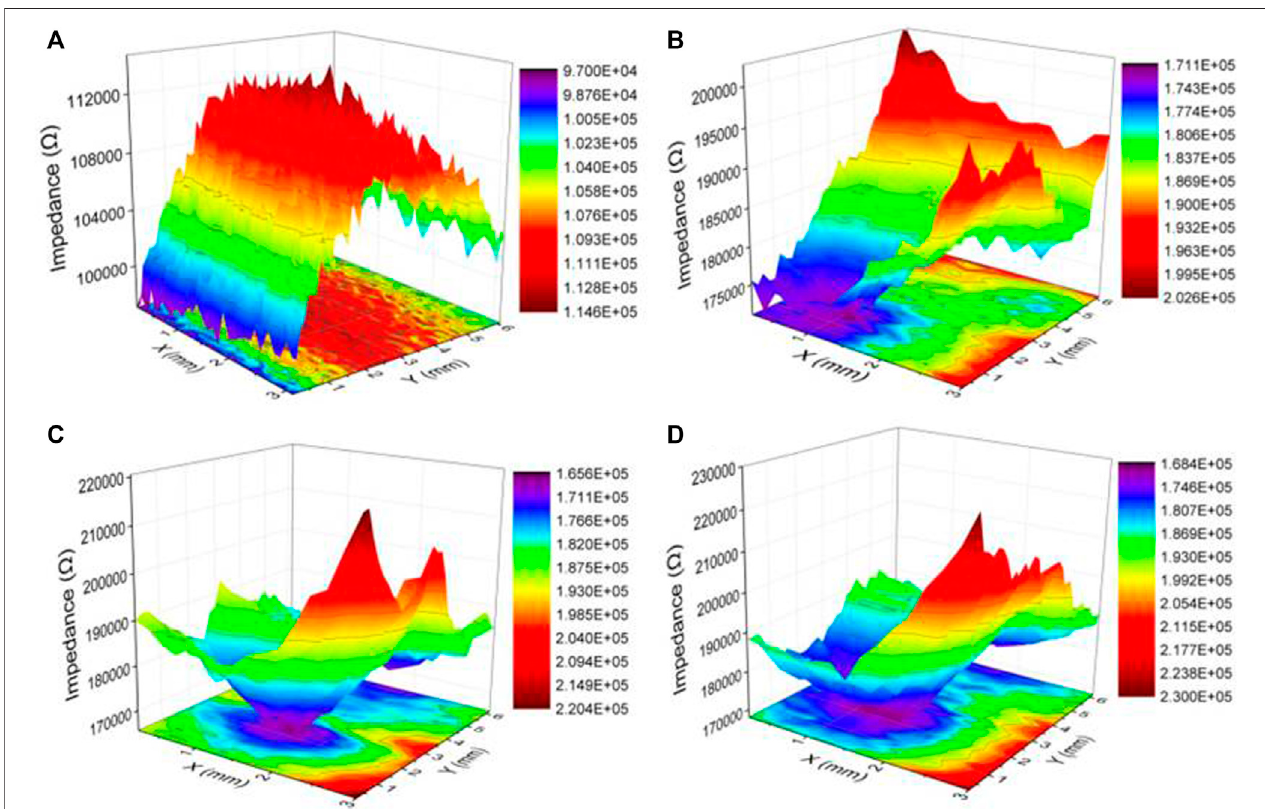
FIGURE 12 | LEIS maps of samples after immersion in a 3.5 wt% NaCl solution [ (A) FSW joint; (B) 50% duty ratio; (C) 80% duty ratio; (D) 100% duty ratio].